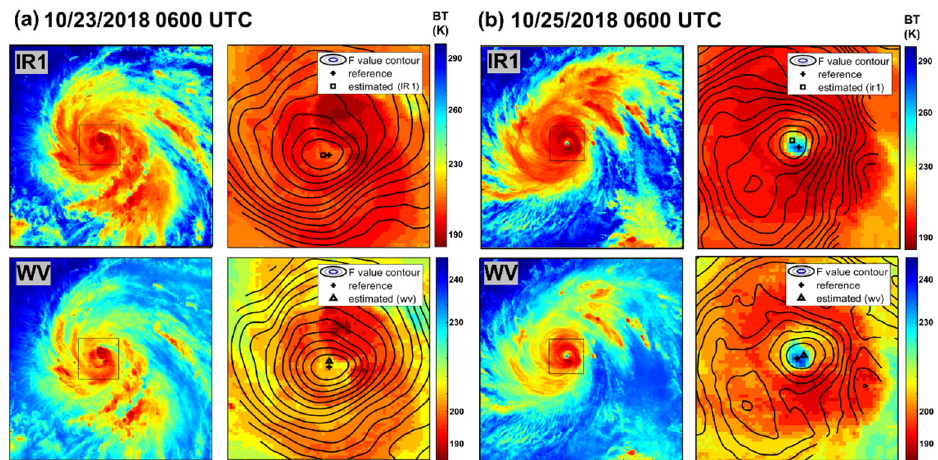
Figure 9. Channel-wise tropical cyclone (TC) observations and TC center estimation results for typhoon YUTU (2018). ( a , b ) are the TCs observed at 23 October 2018 0600 UTC and 25 October 2018 0600 UTC, respectively. The left column of ( a , b ) shows the IR1- and WV-channel-based observation, while the right column depicts the contour lines of the F-value for the area around the center (the black rectangle on the left column).